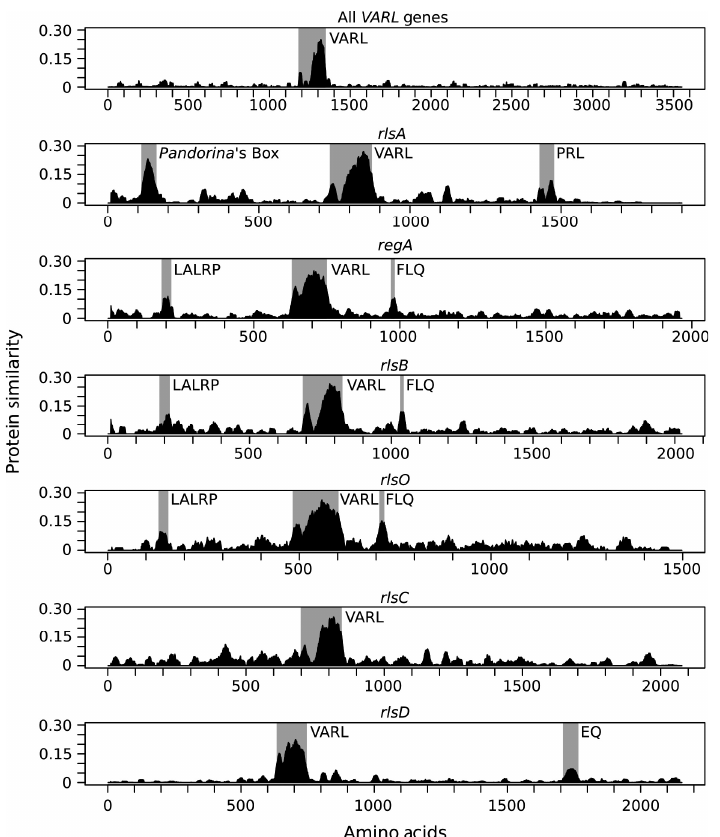
Figure 5. Protein similarity plots for all regA clusters and RLS1/rlsD proteins based on syntenic positions (rlsA, regA, rlsB, rlsO, rlsC, and rlsD). Regions showing high similarity are highlighted with grey boxes. The two peaks in the shaded VARL region represent the N-terminal extension and core VARL domain separated by the less conserved linker region. Reproduced from the study by Grochau-Wright et al. [25].